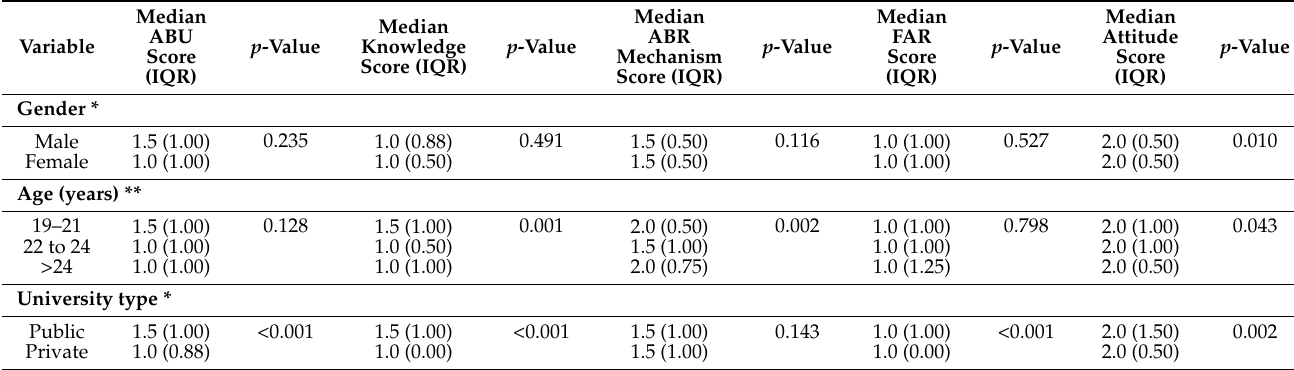
Table 7. Association of median scores with demographic